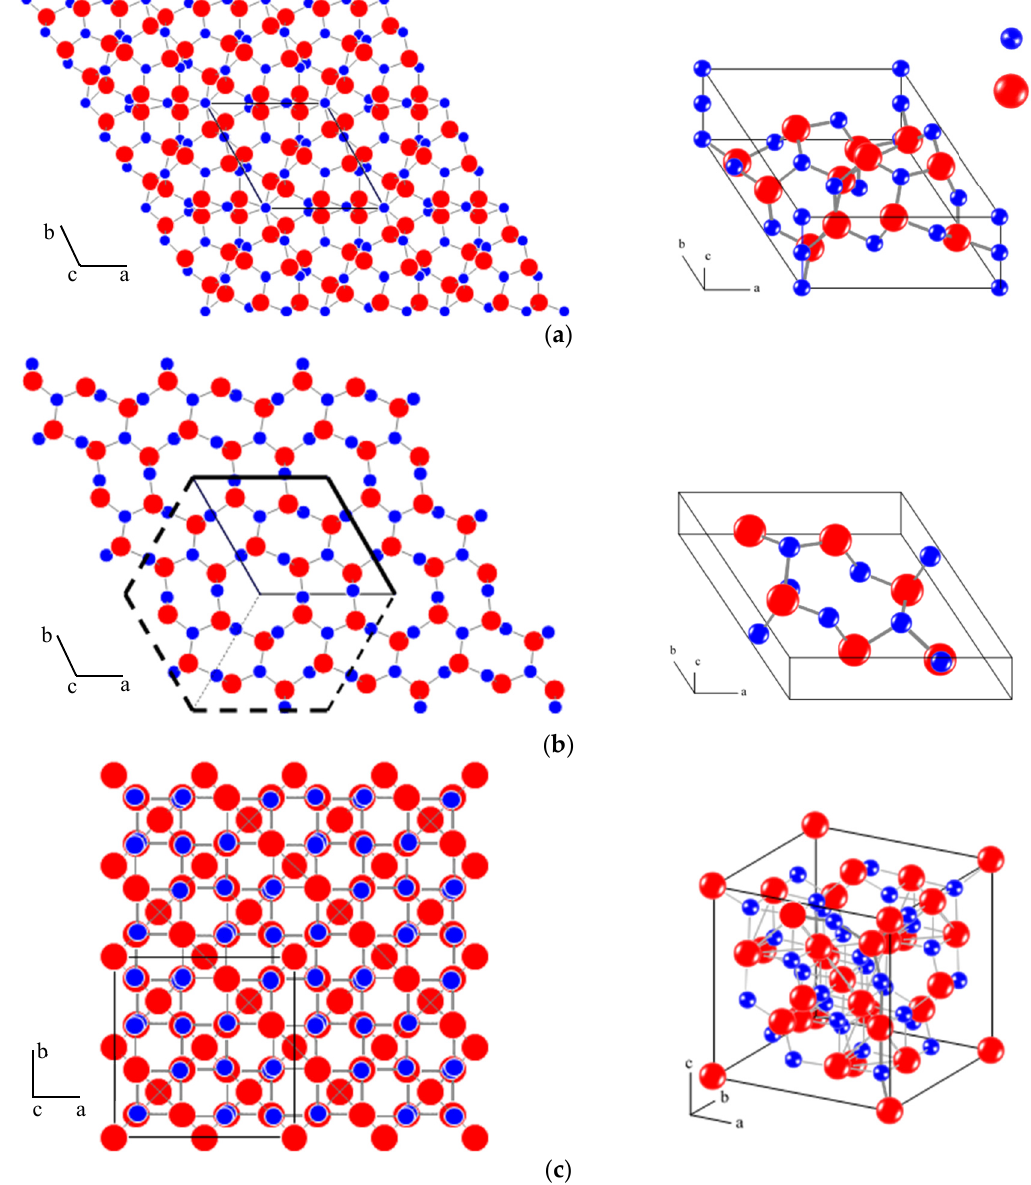
Figure 26. Crystal structure and unit cell of ( a ) α Si 3 N 4 , ( b ) β Si 3 N 4 , showing the hexagonal symmetry, and ( c ) γ Si 3 N 4 .